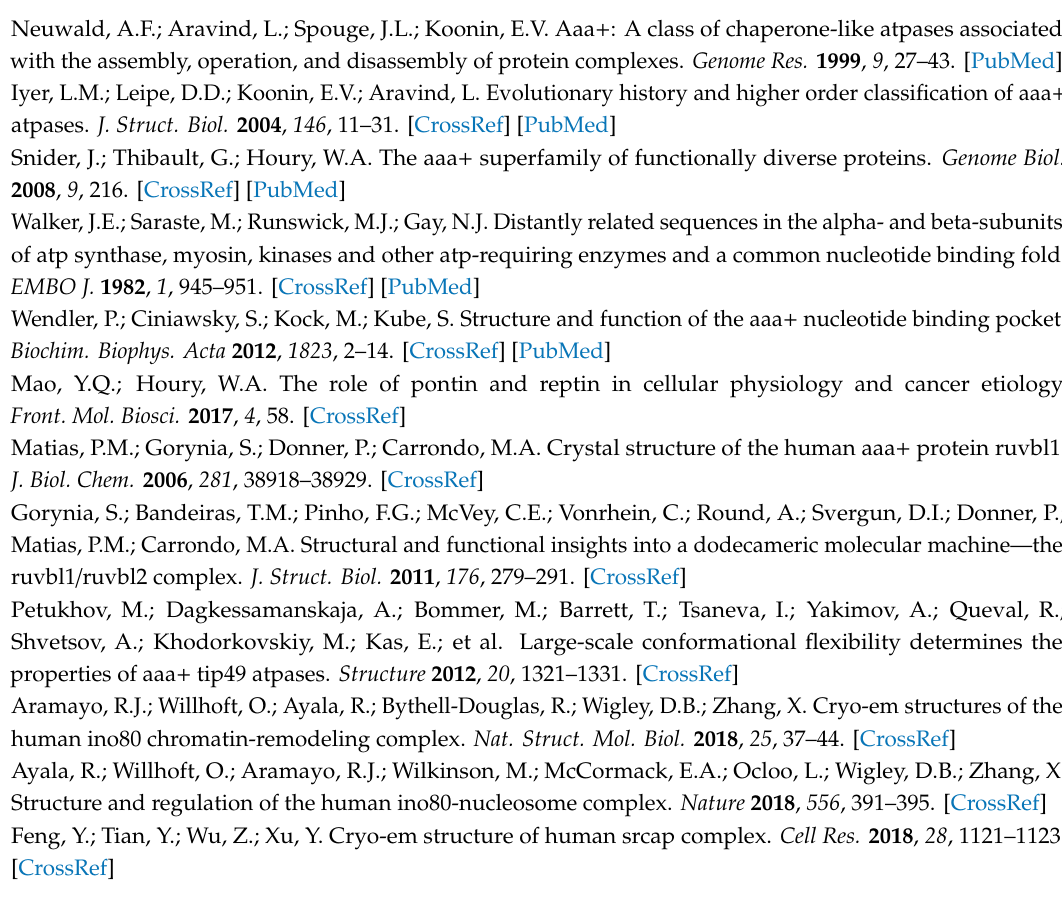
Figure S1: Sorafenib analogs tested against RUVBL2 ATPase activity. Sorafenib analogs tested against RUVBL2 ATPase activity using the ATP / NADH assay. The analogs were also tested for binding to RUVBL2 using Surface Plasmon Resonance. In both assays, none of the analogs were found to inhibit or interact with RUVBL2. Figure S2: Sorafenib has no significant e ff ect on RUVBL2 oligomerization or aggregation Table S1: List of proteins, plasmids and expression strains used in this study. Table S2: List of mutations and primers used for subcloning and mutagenesis in this